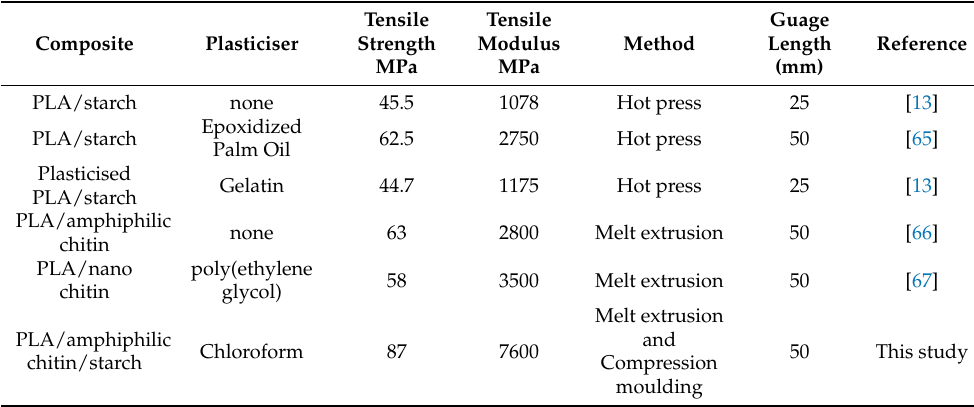
Table 6. Comparative tensile properties with previous